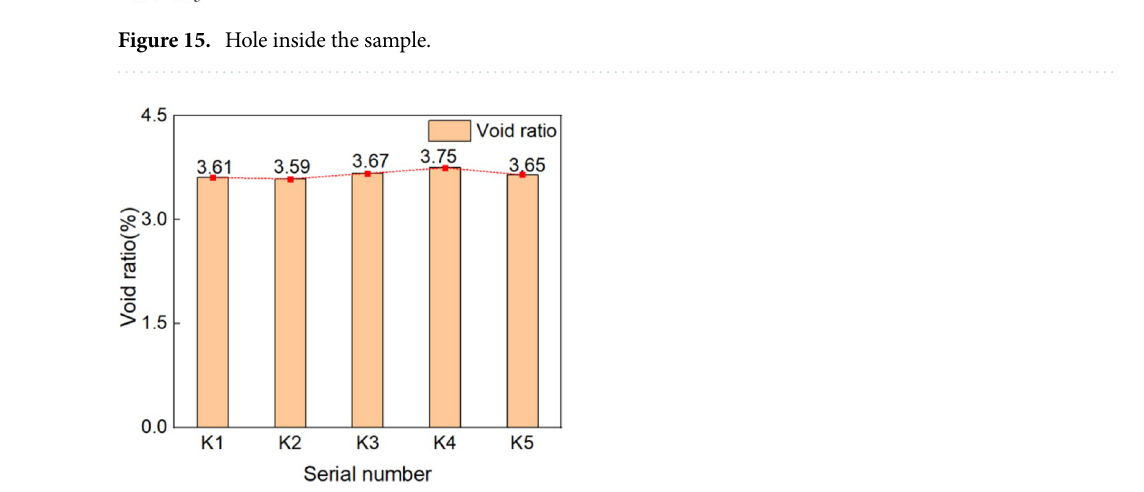
Figure 16. Void ratio